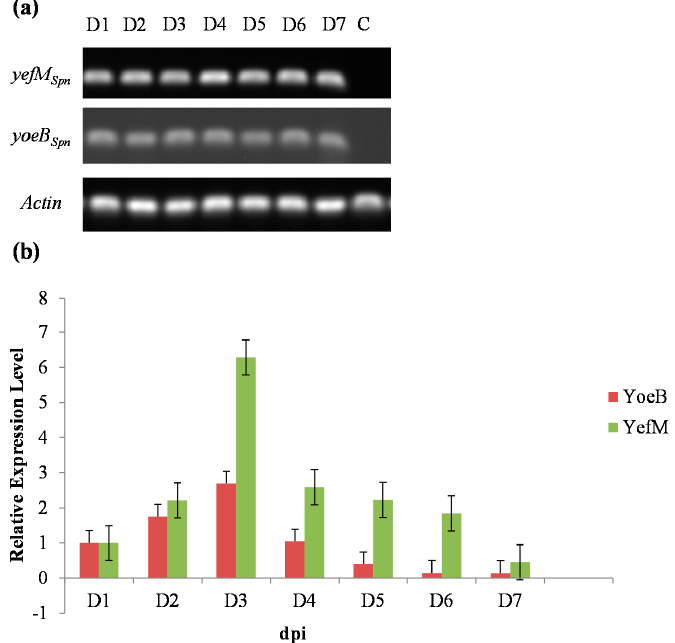
Figure 5. The relative expression levels of yefM Spn and yoeB Spn -GFP transcripts in hybrid plants as determined by qRT-PCR from Day 1 (D1)–Day 7 (D7) after 17- β -estradiol induction. ( a ) Agarose gel electrophoresis following RT-PCR to detect the transgene transcript in the hybrid A. thaliana plants harboring the yefM Spn and yoeB Spn -GFP transgenes. C, wild-type A. thaliana as the control; and ( b ) qRT-PCR analysis of yefM Spn and yoeB Spn -GFP in hybrid plants. Data were normalized to the endogenous A. thaliana actin gene ( Actin ), and the sample taken at Day 1 was set to 1.0. Error bars represent the standard deviation from the RT-PCR amplification of three biological replicates of A. thaliana rosette leaves’ total RNA